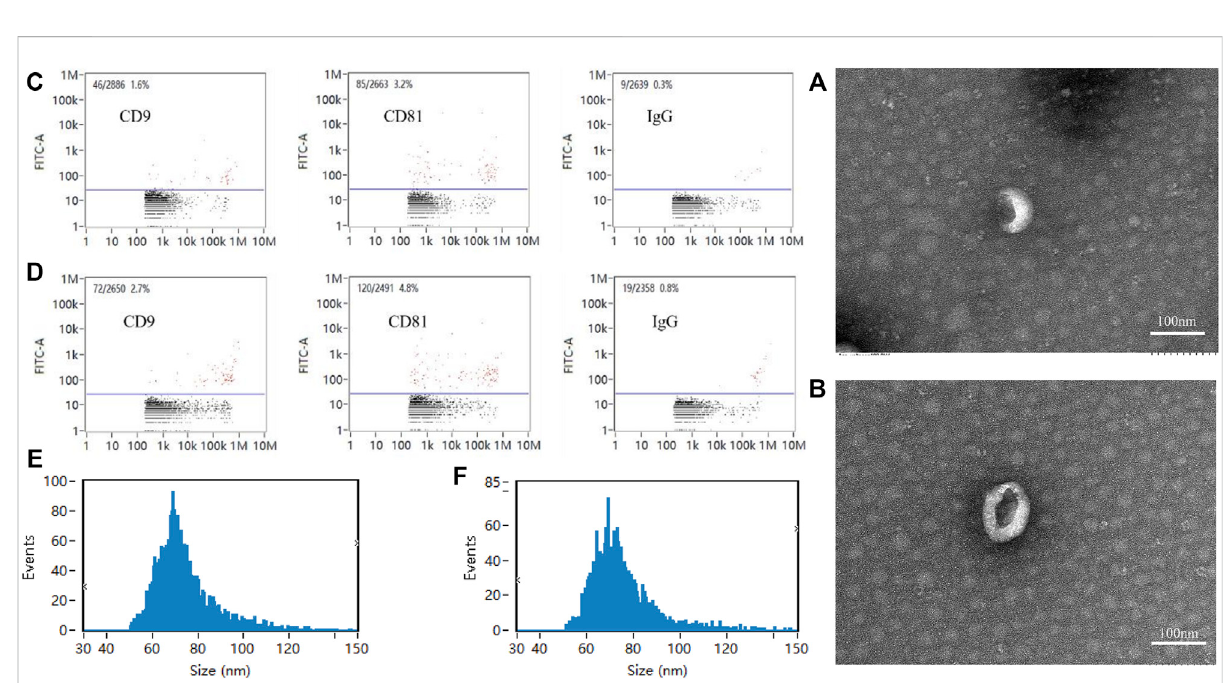
FIGURE 2 Exosome identi fi cation (A) :Control-Exo group TEM image. (B) : Force-Exo group TEM image. (C) : Control-Exo group CD9 and CD81 detection results. (D) : Force-Exo group CD9 and CD81 detection results. (E) : Control-Exo group exosome particle size distribution. (F) : Force-Exo group exosome particle size